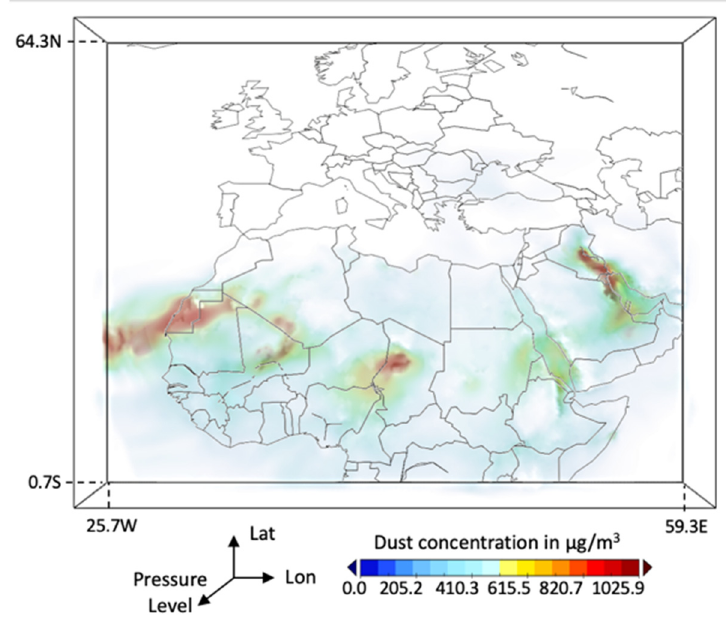
Figure 5. Dust concentration at a certain timestamp.